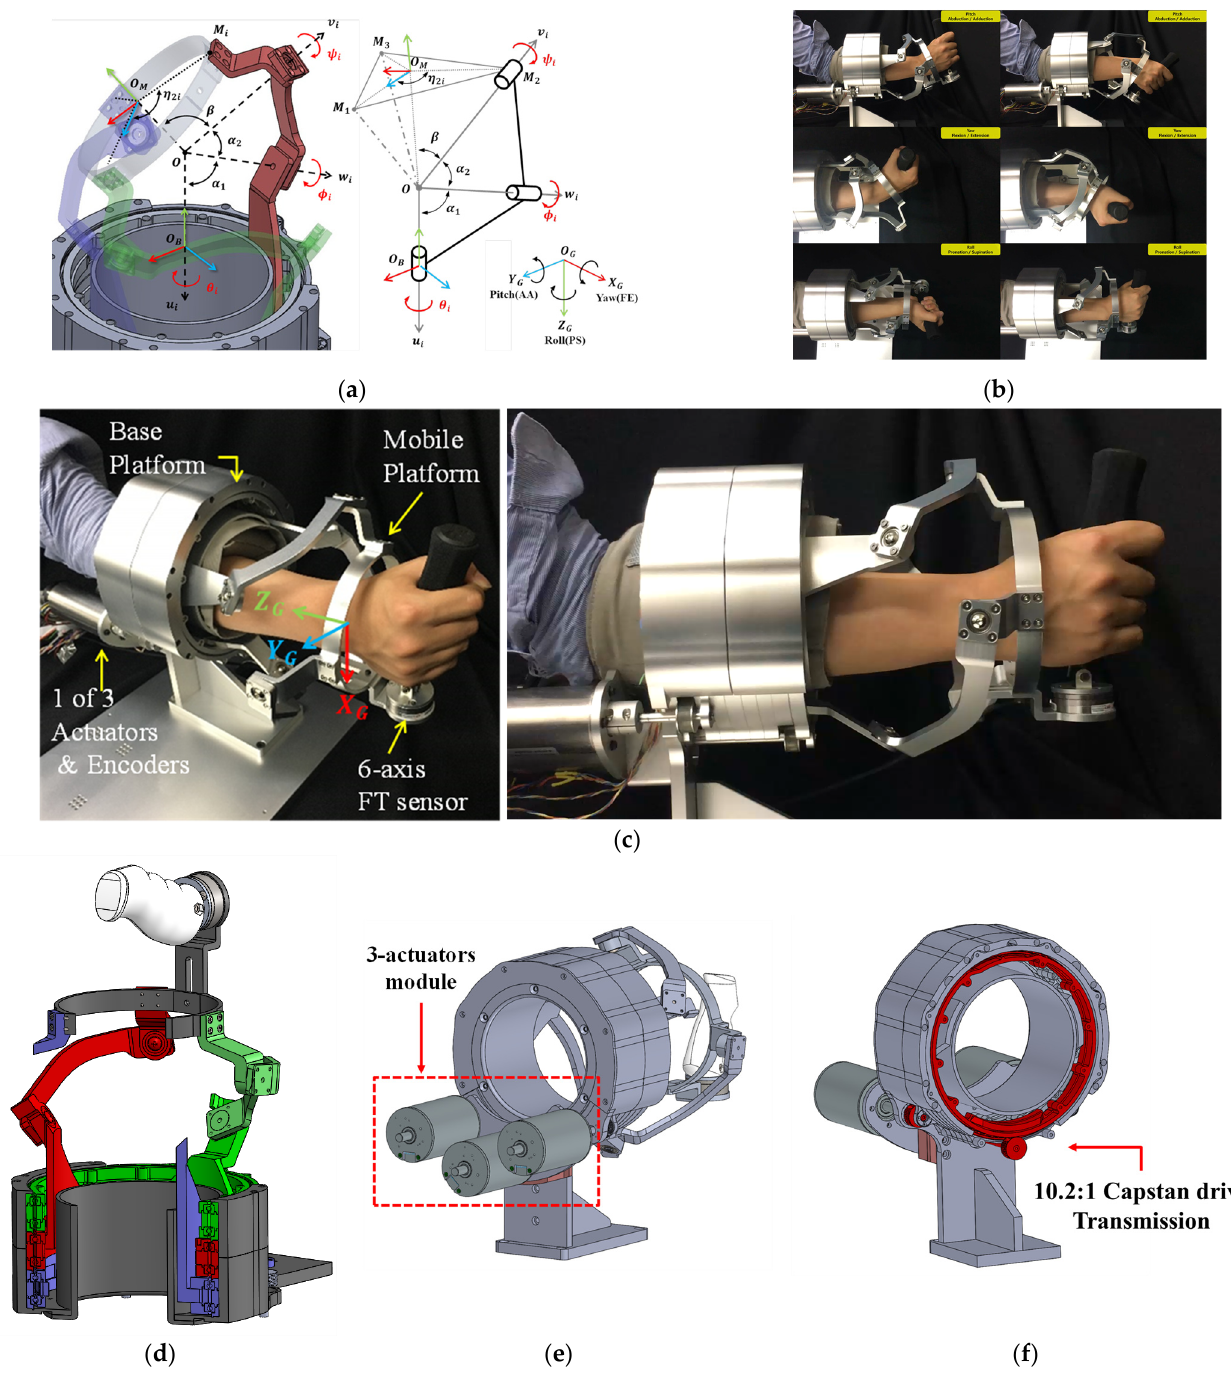
Figure 1. Overview of the FC-WREI: ( a ) represent the kinematic scheme and definition of the geometric design parameters, ( b ) shows some examples of limited poses with human, ( c ) shows the prototype design of the FC-WREI, and ( d ) shows a cross-sectional view. Three actuating slides moving on different tracks on the base. The details of the actuator placement and the transmission are represented in ( e , f ), respectively.